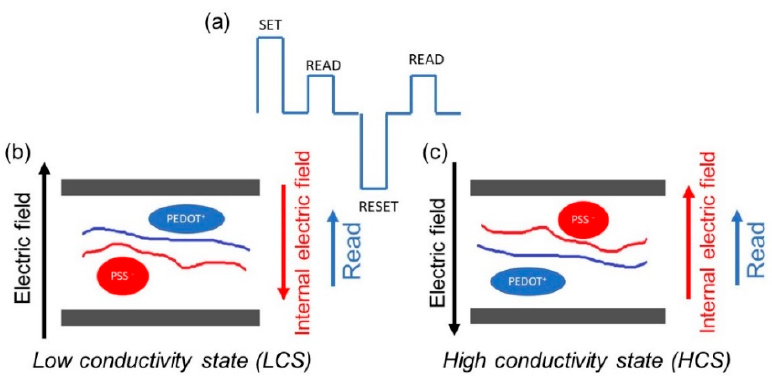
Figure 6. ( a ) Schematic diagrams explaining the memory mechanism in PEDOT:PSS-based memory cells; The device exhibited a ( b ) low conductivity state (LCS) and ( c ) high conductivity state